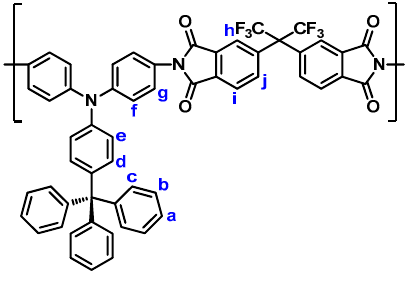
Figure 5. Structure and codes of hydrogen atoms of polyimide 7b .